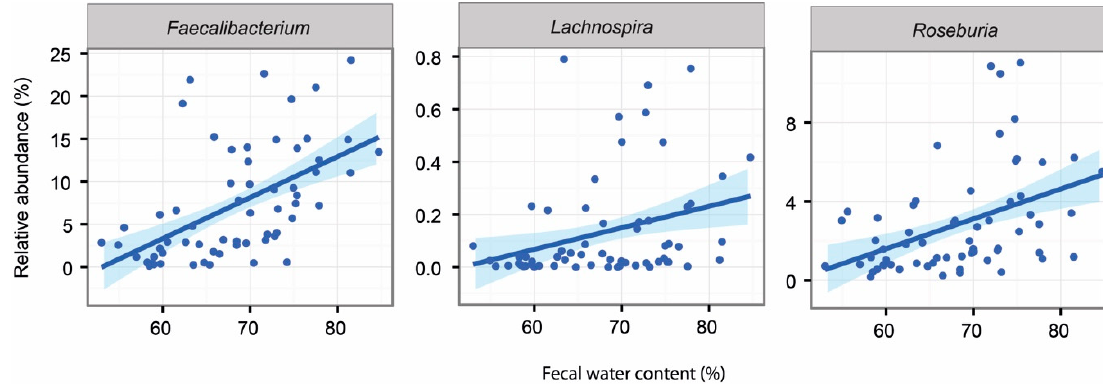
Figure 4. Associations between faecal water content and intestinal genera in constipated subjects at all data points.